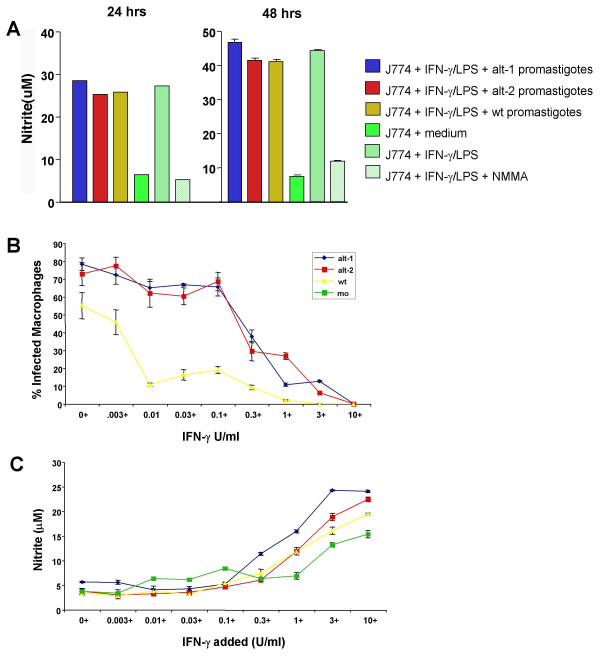
Nitric oxide production and susceptibility to NO-mediated killing. A. Nitrite production in the presence of ALT expression. J774 cells were incubated with medium alone (-ve), or stimulated with IFN-γ (40 U/ml) and LPS (10 ng/ml) (+ve) with or without the arginine analogue N-monomethyl-D-arginine (D-NMMA, 1 mM), or pre-incubated with L. mexicana promastigotes for 4 h before stimulation. Nitrite accumulation in the medium over the subsequent 24 h or 48 h was used as an indicator of NO production and was assayed by the Griess reaction. Each bar represents mean ± standard deviation. B. Survival of transfected Leishmania in activated macrophages. Bone marrow-derived macrophages stimulated with 100 ng/ml LPS and the indicated concentrations of IFN-γ were infected with stationary phase promastigotes of wild-type L. mexicana or transfected alt-1 and alt-2 parasites at a ratio of 10 parasites per cell. After 72 h at 37°C the cells were stained with Giemsa. The percentage of macrophages infected with parasites was determined by counting 4 samples of 100 cells. Each bar represents mean ± standard error of the mean. C. Nitrite production in response to dose of exogenous IFN-γ. Supernatants from the experiment described above (Figure 3B) were recovered and assayed by the Griess reaction for accumulated nitrite. Mo denotes uninfected macrophages. Each bar represents the mean ± standard deviation.